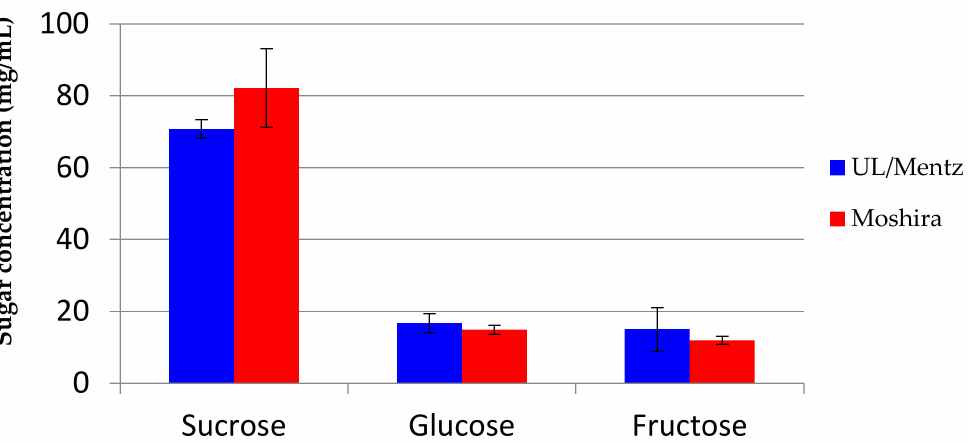
Figure 1. Sucrose, glucose and fructose content in marula juice from UL and